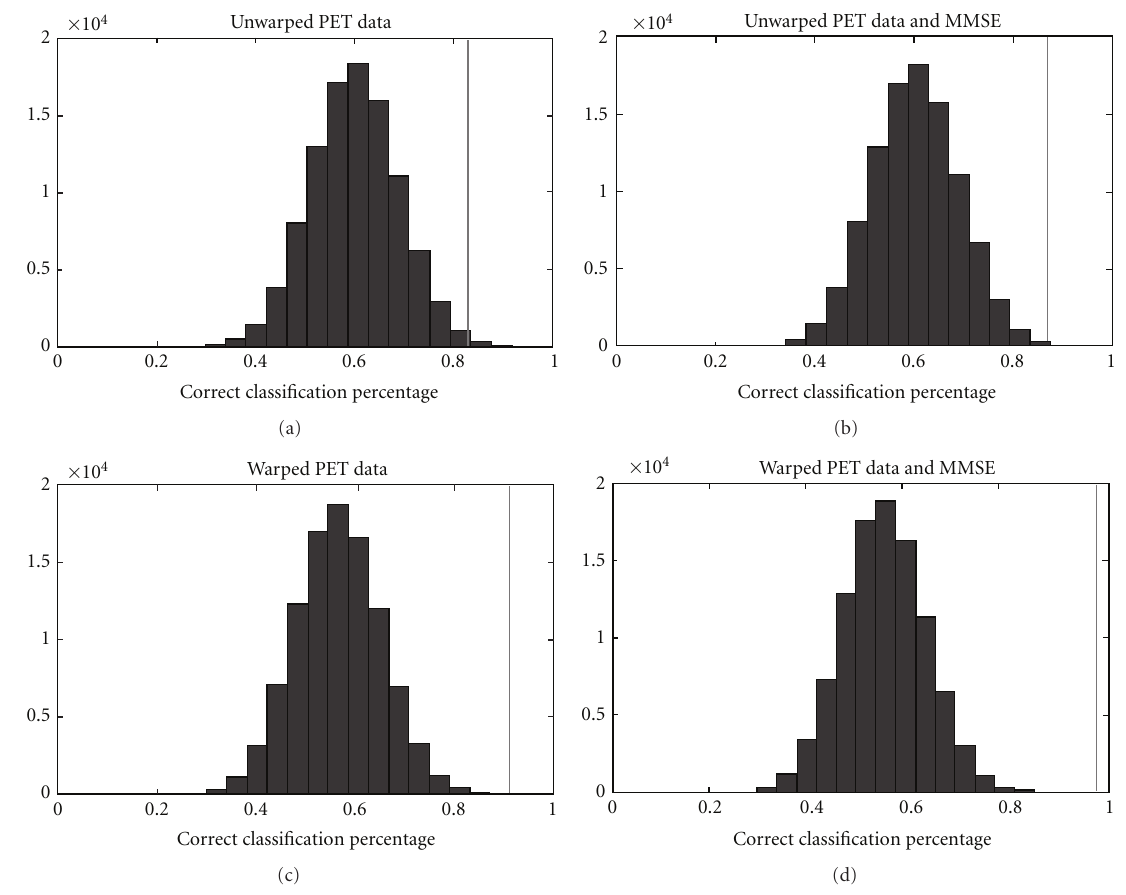
Figure 4: Classification percentages of permutation test. Data shown are for the models using (a) unwarped data only, (b) unwarped data and MMSE, (c) warped data only, and (d) warped data and MMSE. The vertical line represents the score of the true